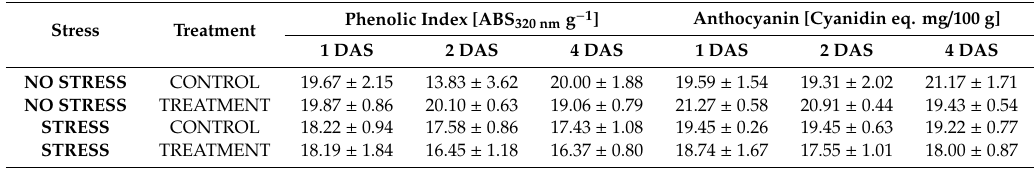
Table 1. Phenolic index and anthocyanin concentration in rocket leaves treated with water (CONTROL) and with borage extract (TREATMENT) and subjected to salt stress (200 mM). Measures were taken after one day, two days, and four days of stress. Values are means ± SE ( n = 4). Data were subjected to two-way ANOVA. Different letters, where present, represent significant differences ( p < 0.05).